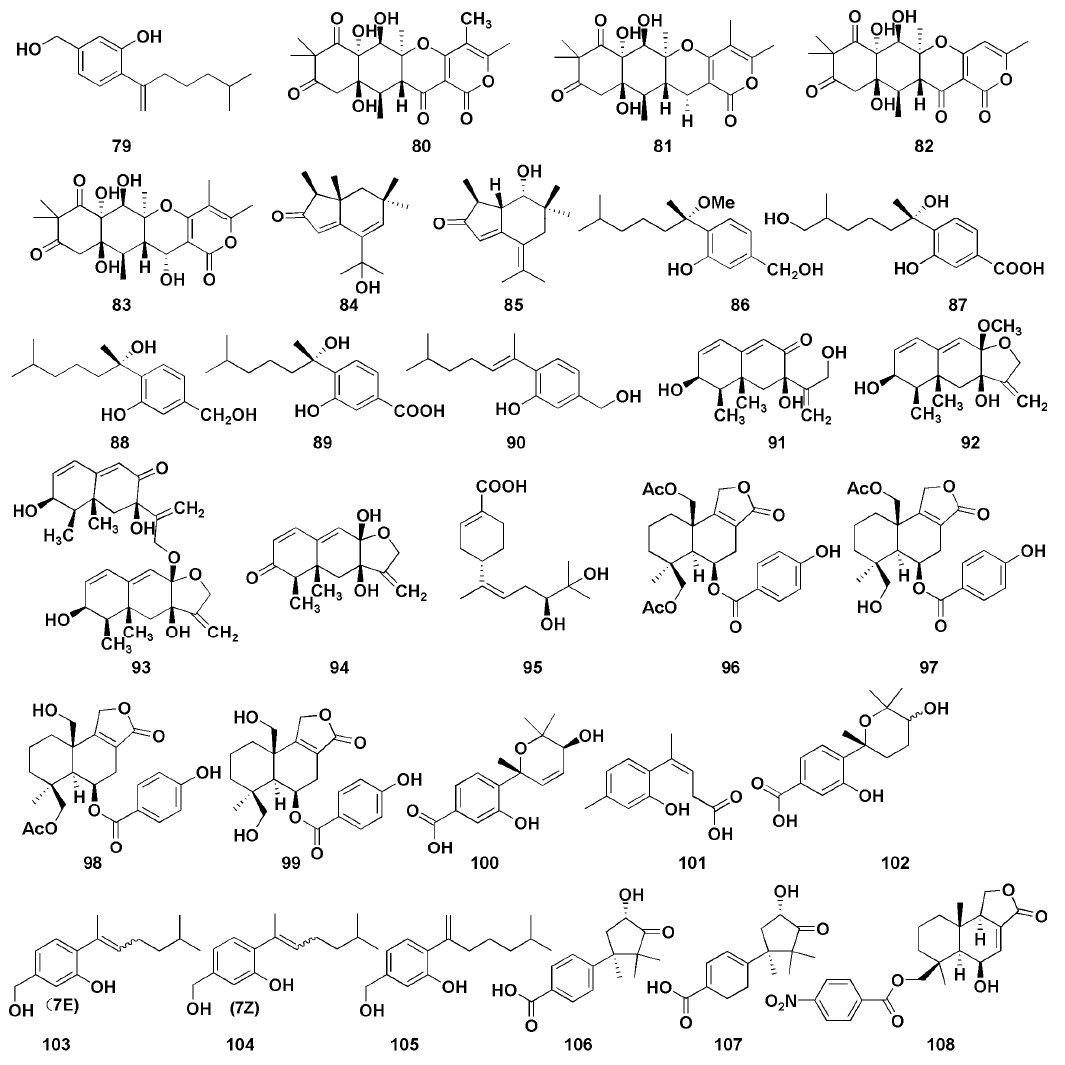
Figure 7. Chemical structures of anti-inflammatory compounds ( 79 – 108